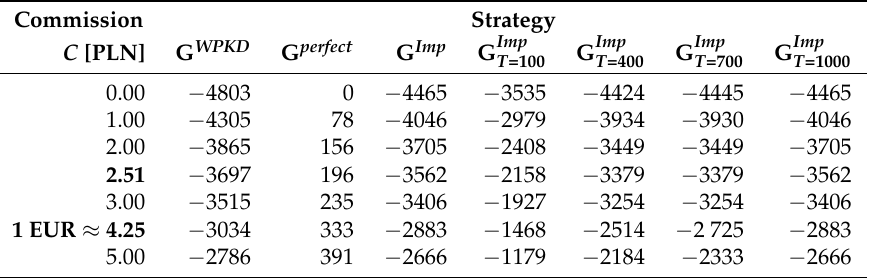
Table 2. Comparison of daily VaR 95% values for the different strategies considered and the whole two-year out-of-sample evaluation period, see Figures 1 and 2. Two values of C are emphasized in bold: 2.51 PLN, which yields a zero profit for the G Imp strategy (see Table 1), and 1 EUR ≈ 4.25 PLN.